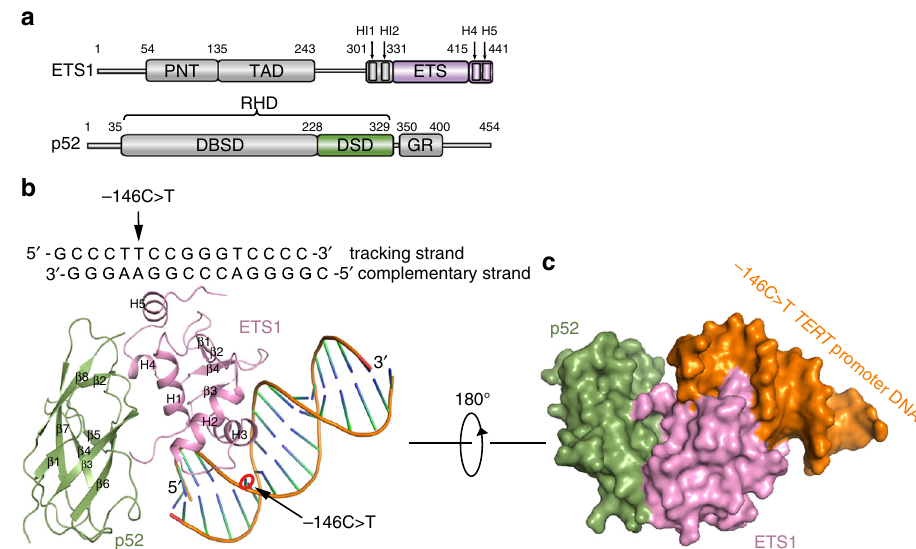
Fig. 1 Overall structure of p52/ETS1/ − 146C>T mutant TERT promoter complex. a Color-coded domain architecture of human ETS1 and p52. The pink and green color schemes are used in the structural fi gures of p52/ ETS1/ − 146C>T TERT promoter fragment complex. PNT PNT domain, TAD acidic transactivation domain, ETS ETS DNA-binding domain, RHD Rel homology domain, DBSD DNA-binding subdomain of RHD, DSD dimerization subdomain of RHD, GR glycine-rich region. b Ribbon diagram of the ternary complex. c Surface representation of the ternary